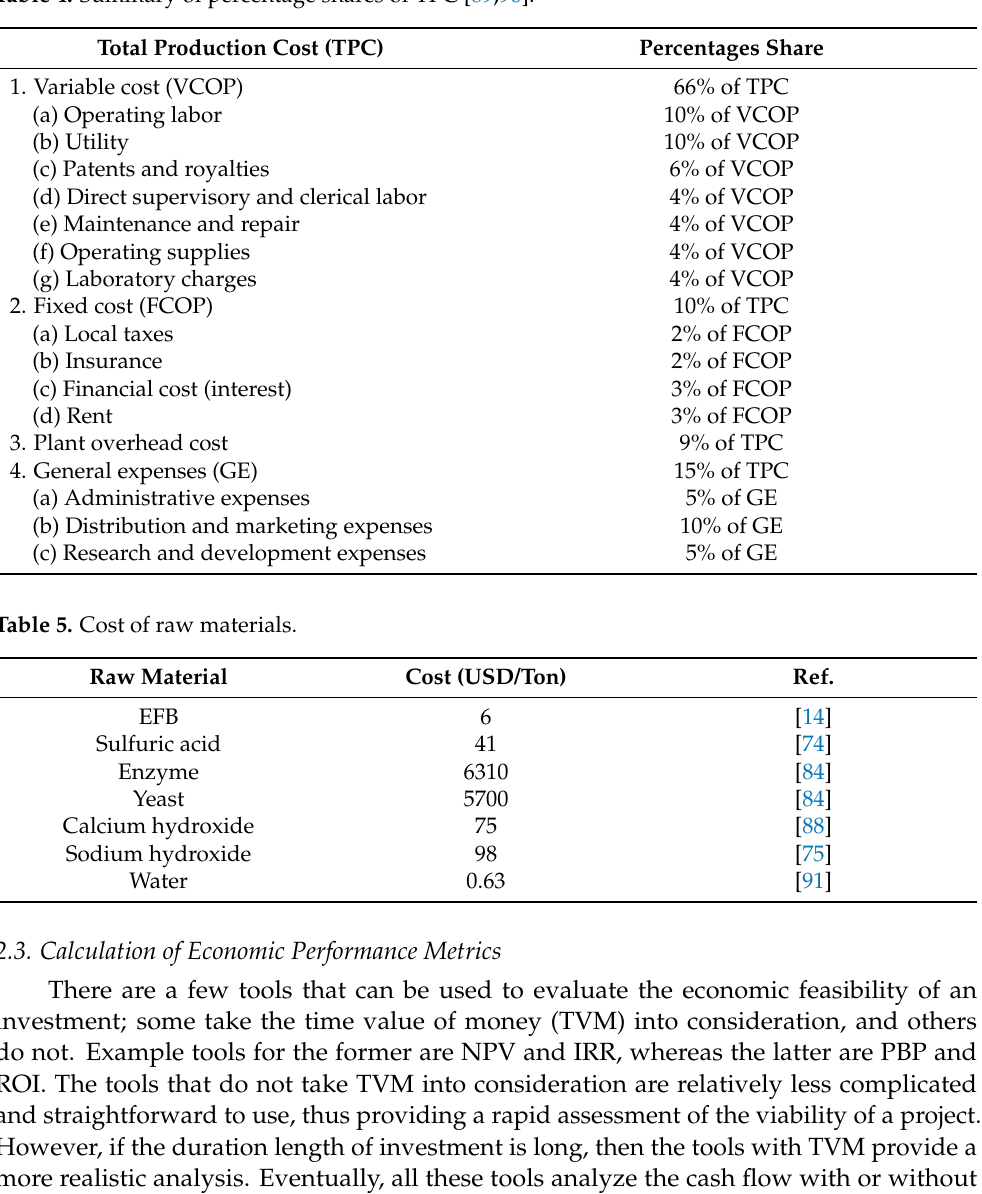
Table 4. Summary of percentage shares of TPC [89,90].